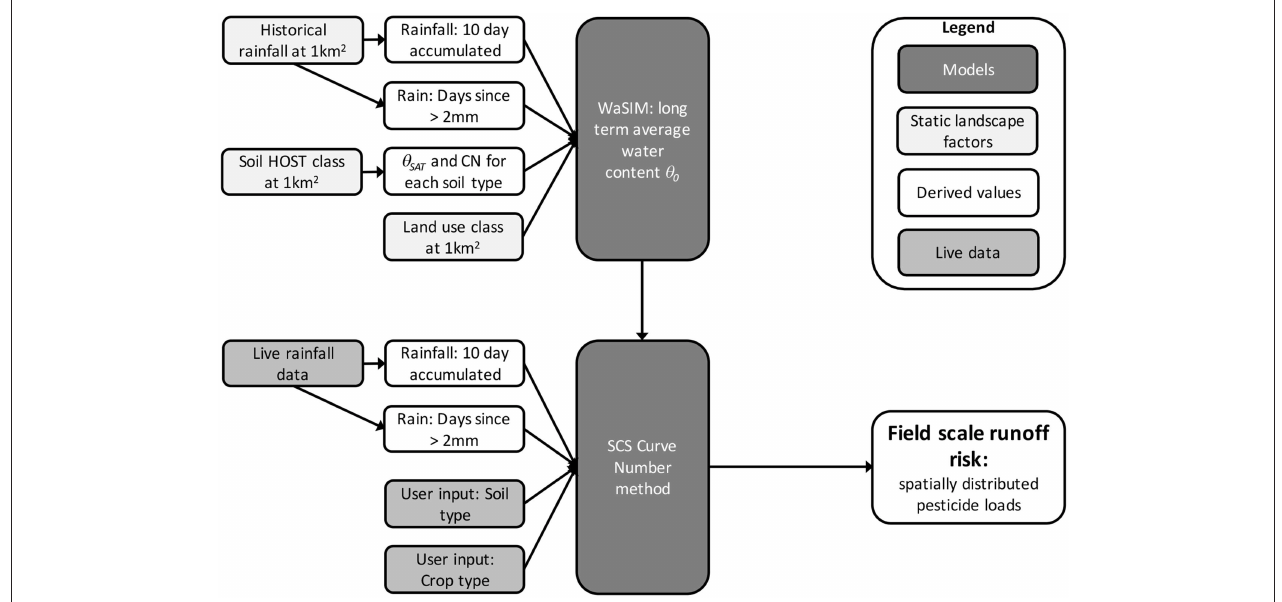
FIGURE 1 | The field scale runoff risk